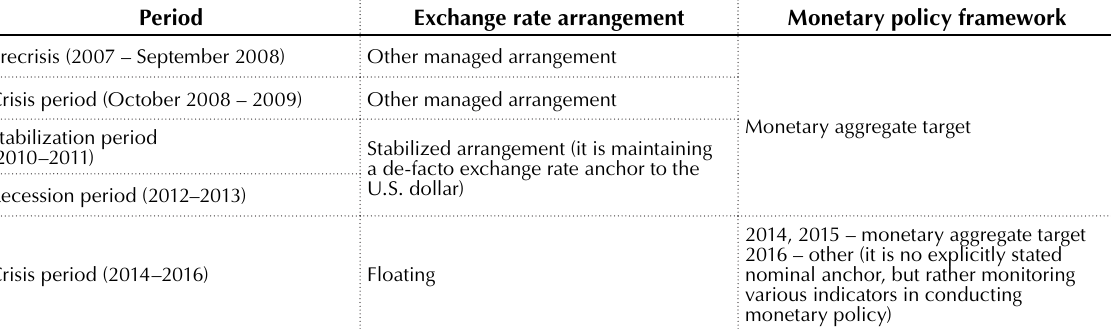
Table 2. Exchange rate arrangements and monetary policy framework in Ukraine during 2007–2016 years by the IMF